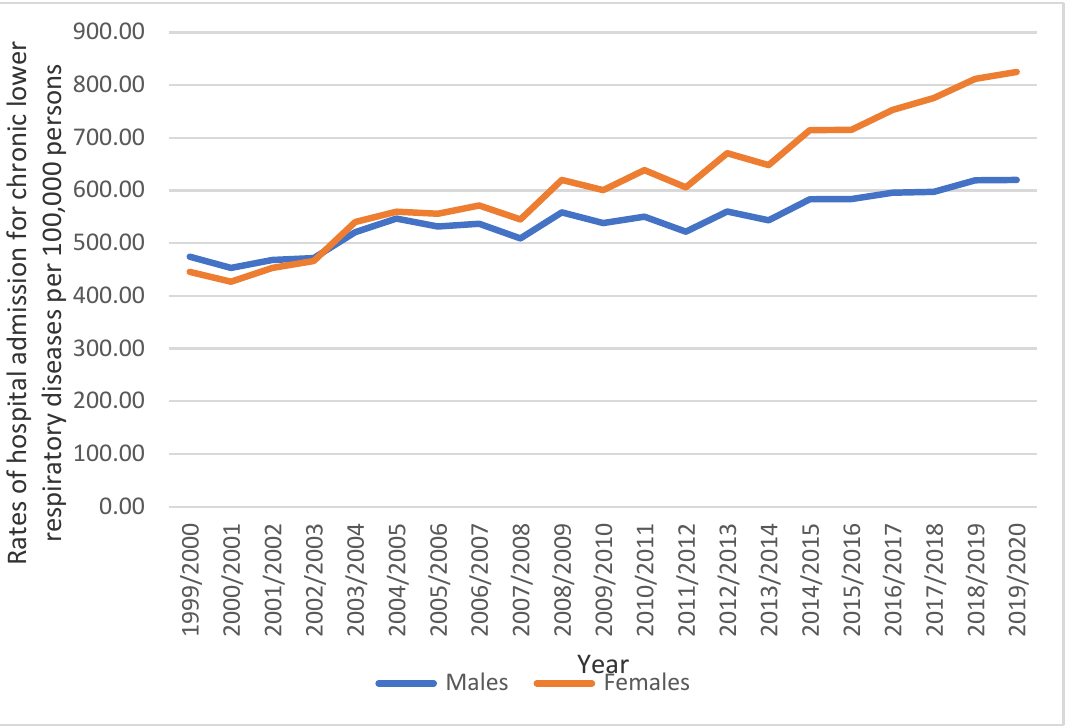
Figure 3. Rates of hospital admission for chronic lower respiratory diseases in England and Wales stratified by gender.